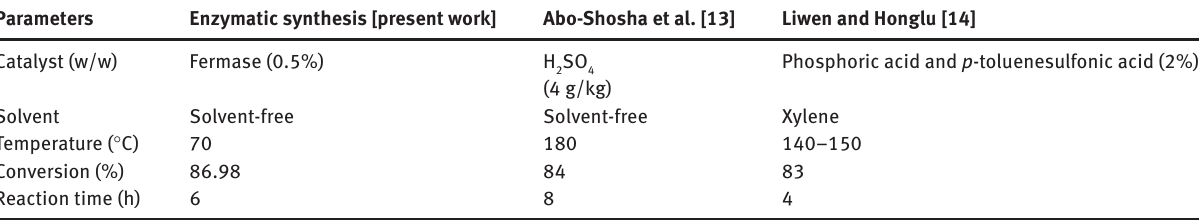
Table 1: Comparison between the enzyme-catalyzed and the conventional acid-catalyzed synthesis of polyethylene glycol stearate.